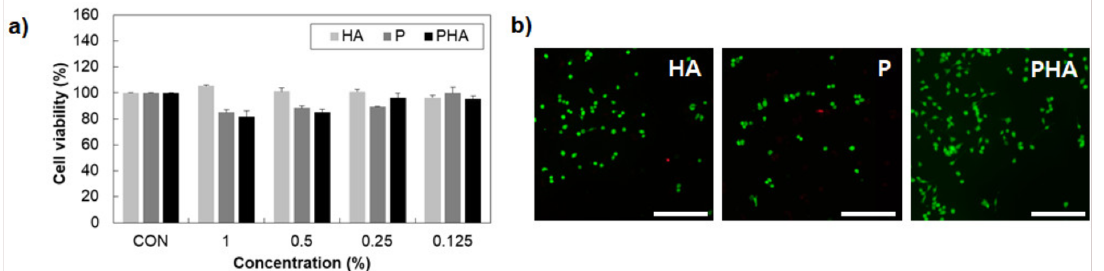
Figure 5. Cell viability of MDA-MB-231. ( a ) The MTT assay (n = 3) and ( b ) Live/Dead assay. The non-treated group was used as the control. Fluorescence microscopy images of MDA-MB-231 were obtained after 1 day of treatment with HA (0.042 wt.%), P (0.5 wt.%), and PHA (0.5 wt.%). The cells are stained using a Live (green)/Dead (red) kit, and the image showed green and red as live and dead cells, respectively. The scale bar is 200 µ